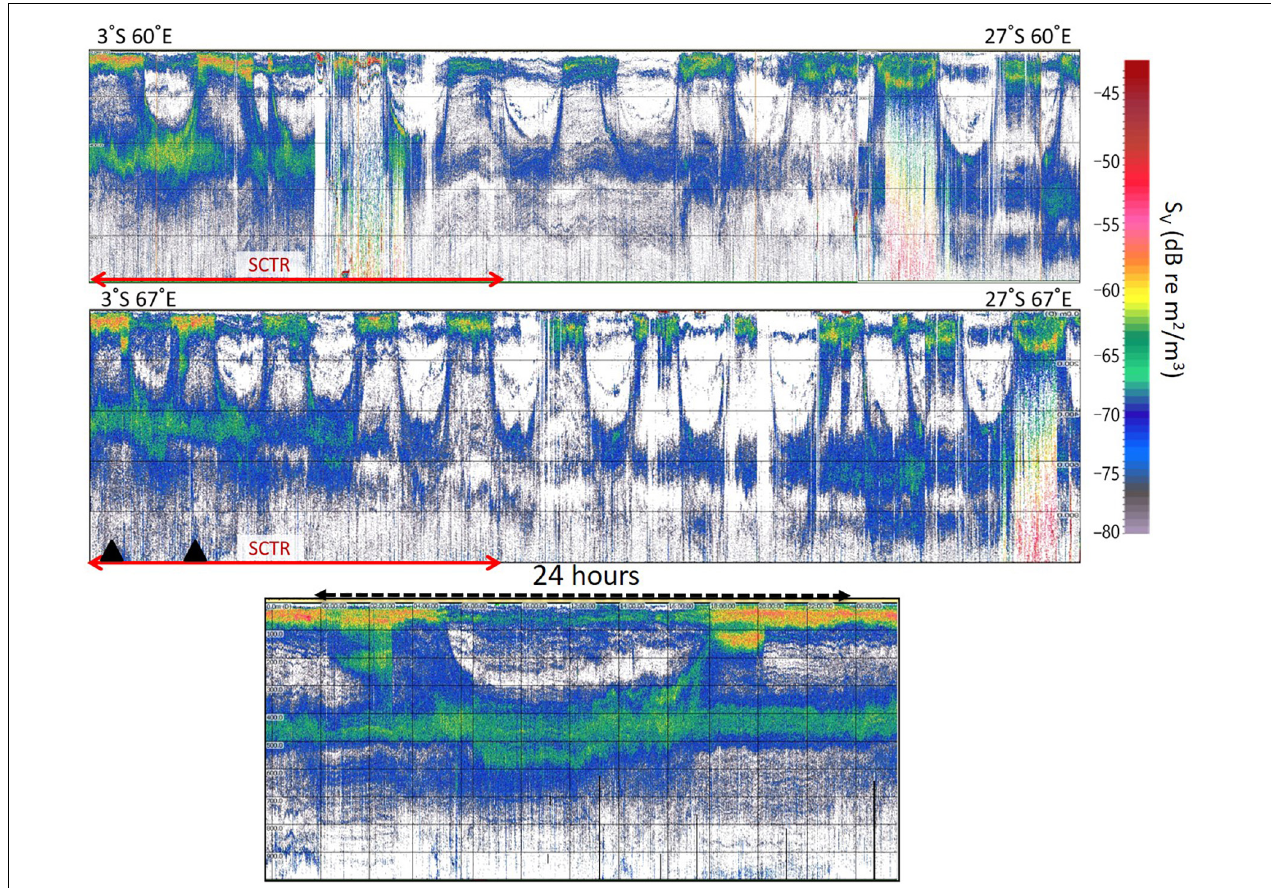
FIGURE 2 | Diurnal migration pattern of acoustic scatterers. Clear diurnal migrations are visible in 200–800 m depth. Diurnal migration of 400–800 m in the SCTR (marked with red arrows) was clearer and shallower than that in the non-SCTR. The top echogram starts from the latitude of 3 ◦ S to 27 ◦ S in 60 ◦ E of longitude. The middle echogram begins from 3 ◦ S to 27 ◦ S in 67 ◦ E. A 24 h echogram (bottom) was recorded on May 2 of 2019 and was derived from two black triangles of the middle echogram. The horizontal lines every 200 m depth are shown in all